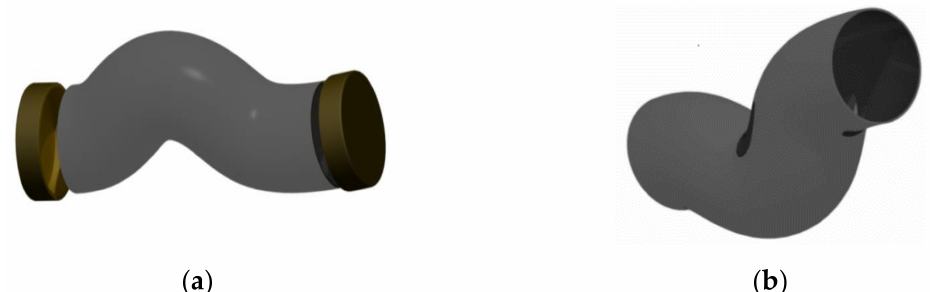
Figure 2. Physical appearance of the concerned product: ( a ) Product composed by a steel body tube and two polymer protections; ( b ) Product composed by a steel body tube.